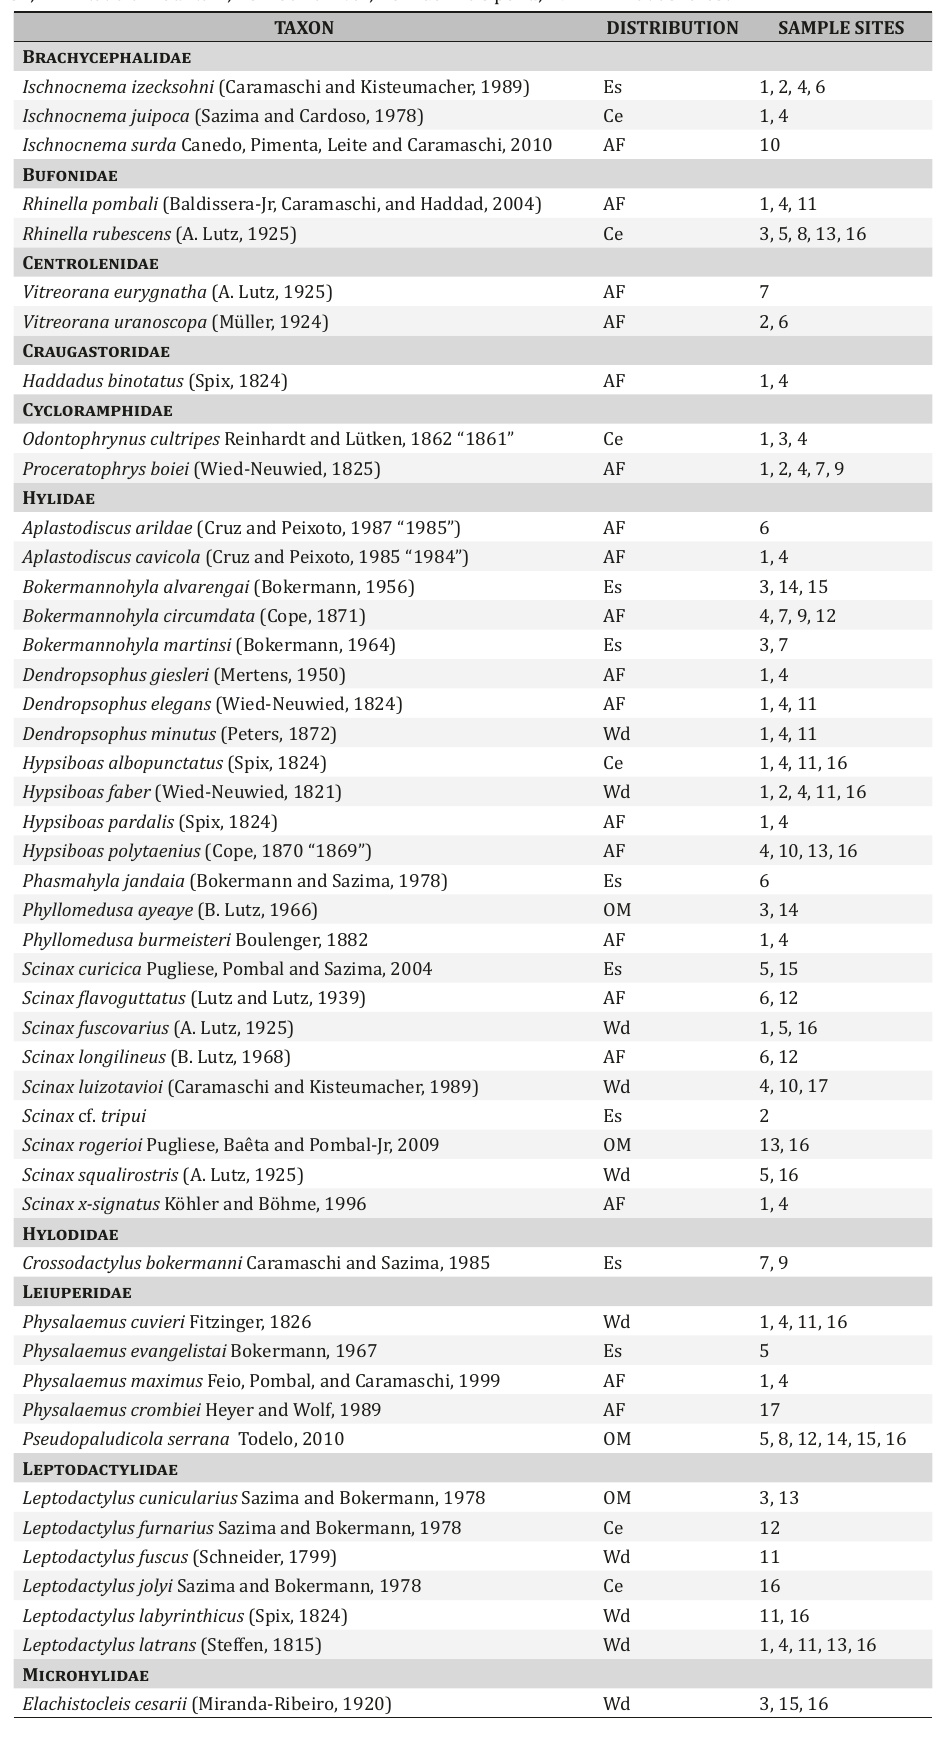
Table 2. Distribution classes: List of anuran species reported for the region of Serra do Ouro Branco, Espinhaço Range, Minas Gerais, southeastern Brazil, between 2003 and 2007, with data about their geographic distribution and sites of occurrence. AF – restricted to Atlantic Forest; Ce – restricted to Sample Cerrado; Es – restricted to Espinhaço Range; OM – restricted to opened areas in mountainous regions; Wd – Widely distributed (it is not restricted to one morphoclimatic domain or mountain range). TAXON DISTRIBUTION SAMPLE SITES